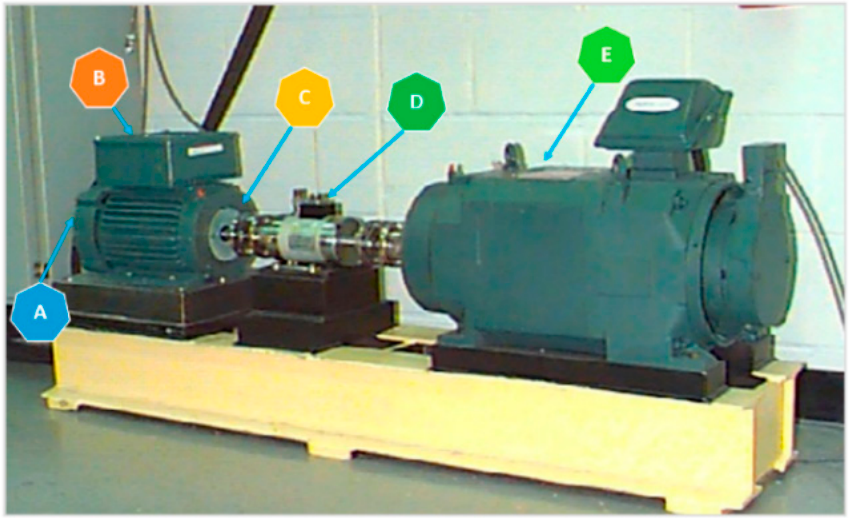
Figure 6. Bearing test ring tests from [108], Copyright 2019, MDPI. A = fan end bearing; B = electronic motor; C = drive end bearing; D = torque transducer; E = dynamometer.